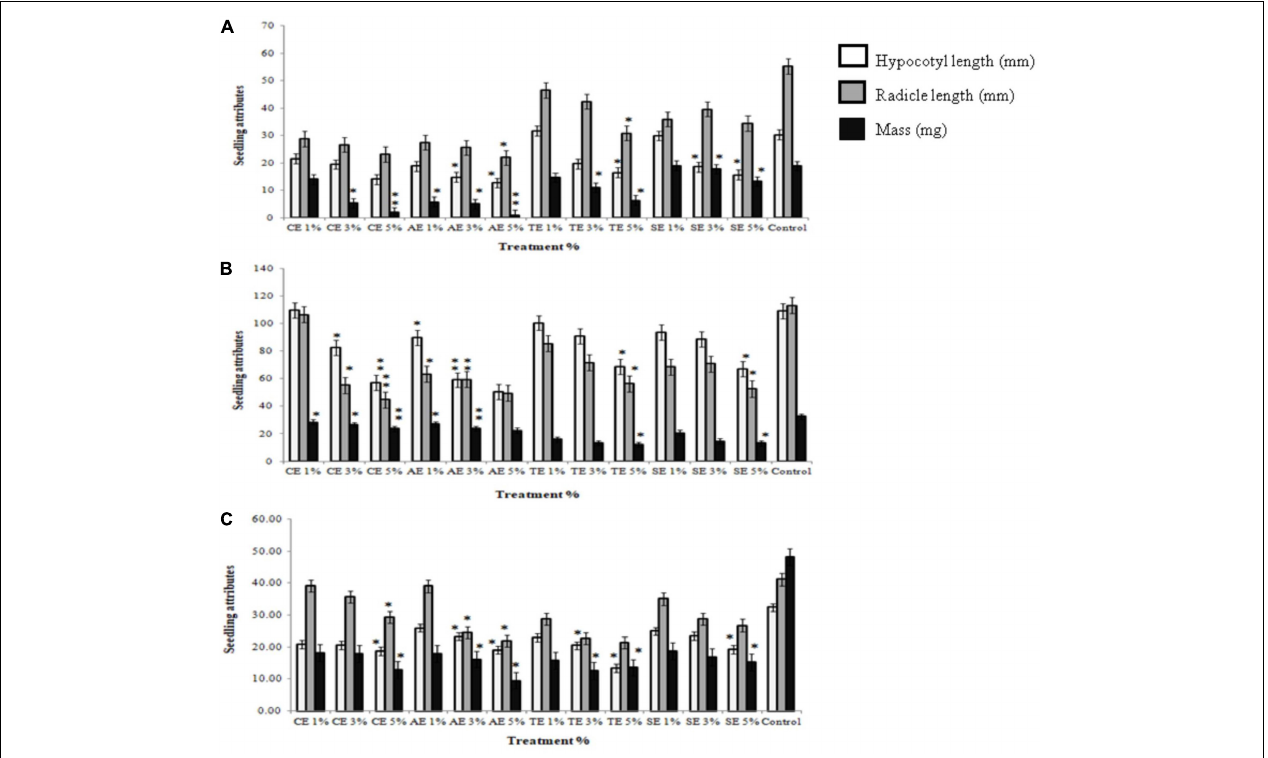
FIGURE 2 | Seedling attributes of weeds after treatment with castor extract (CE), artemisia extract (AE), wheat extract (TE), sorghum extract (SE), and aqueous control. (A) Effect on Sinapis arvensis ; (B) effect on Lolium multiflorum ; (C) effect on Parthenium hysterophorus . Values are presented as mean ± SEM ( n = 30). Bar values with asterisks differ significantly from control at P < 0.05.